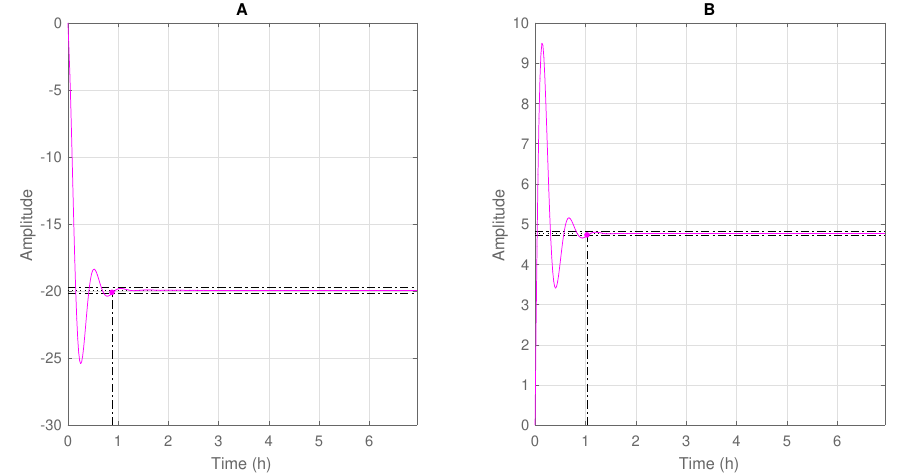
Figure 7. Steady state profile of w po —Rojas Soares et al.